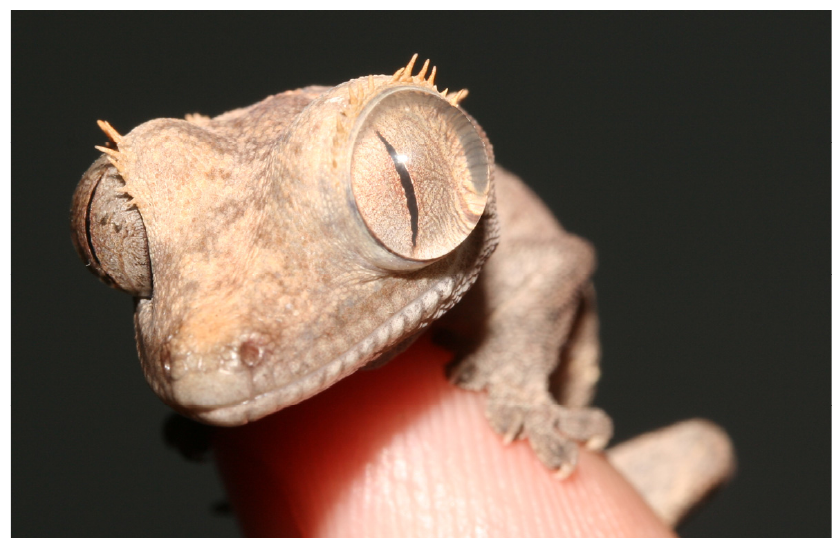
Figure 22. Pseupdobuphthalmos in a juvenile crested gecko ( Correlophus ciliatus ) resulting from developmental abnormalities of the lacrimal drainage system.